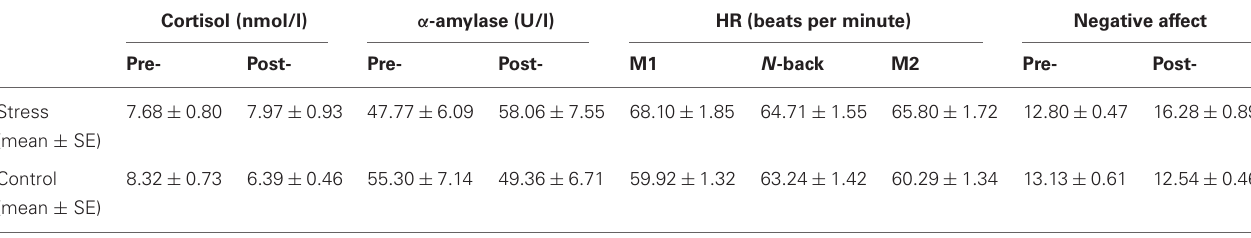
Table 2 | Physiological and psychological measurements of stress ( n = 39).